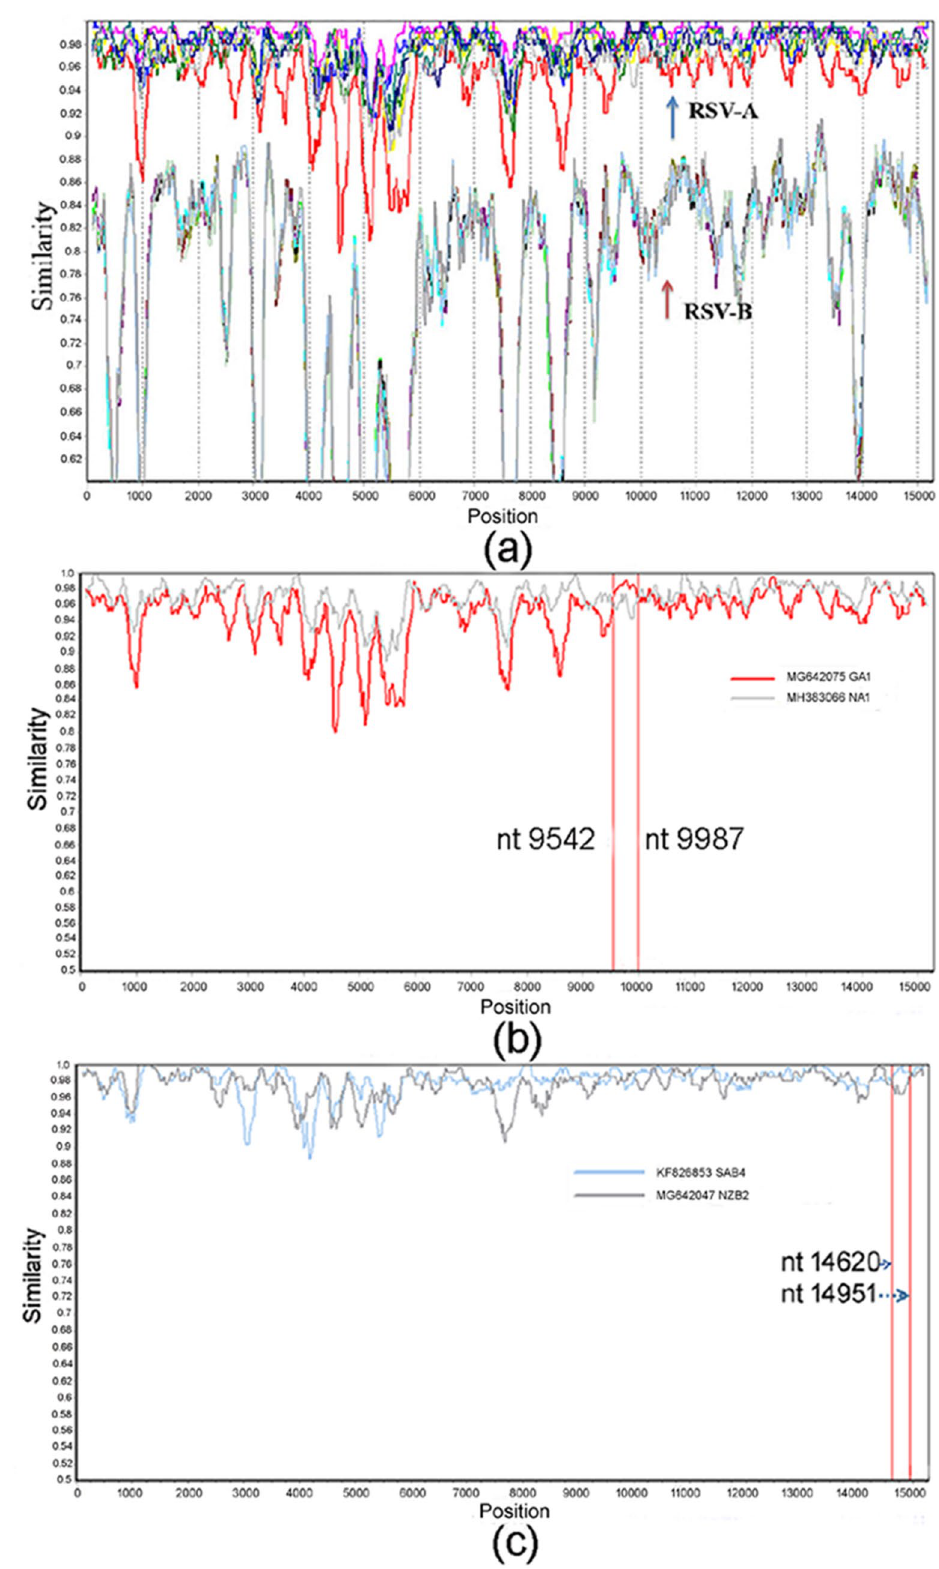
Figure 1. Recombination analysis in RSVs by using representative subtypes/genotypes. ( a ) RSV-A and RSV-B: no recombination event was observed; ( b ) RSV-A and ( c ) RSV-B: potential recombination breakpoints in the intragroups were marked in red lines and the positions were